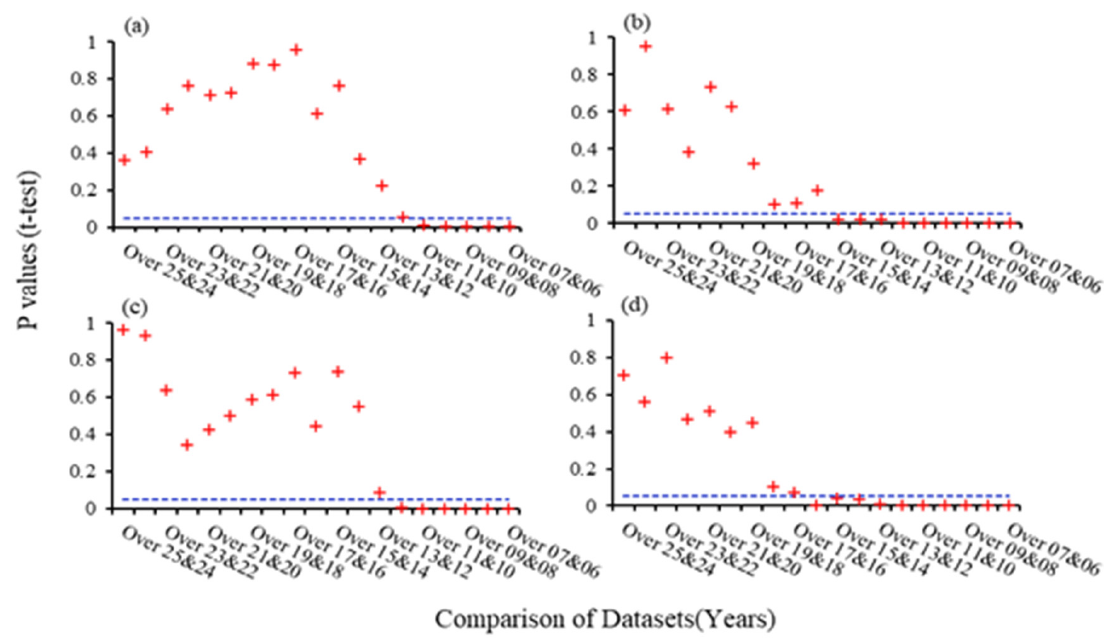
Figure 6. Hypothesis test results for ( a ) Doki River Basin ( b ) MOPEX ID 3504000 ( c ) MOPEX ID 2387500 and ( d ) MOPEX ID 2448000. + + + p values resulting from the comparison of subsets; ------ Values of 5% Confidence Interval.